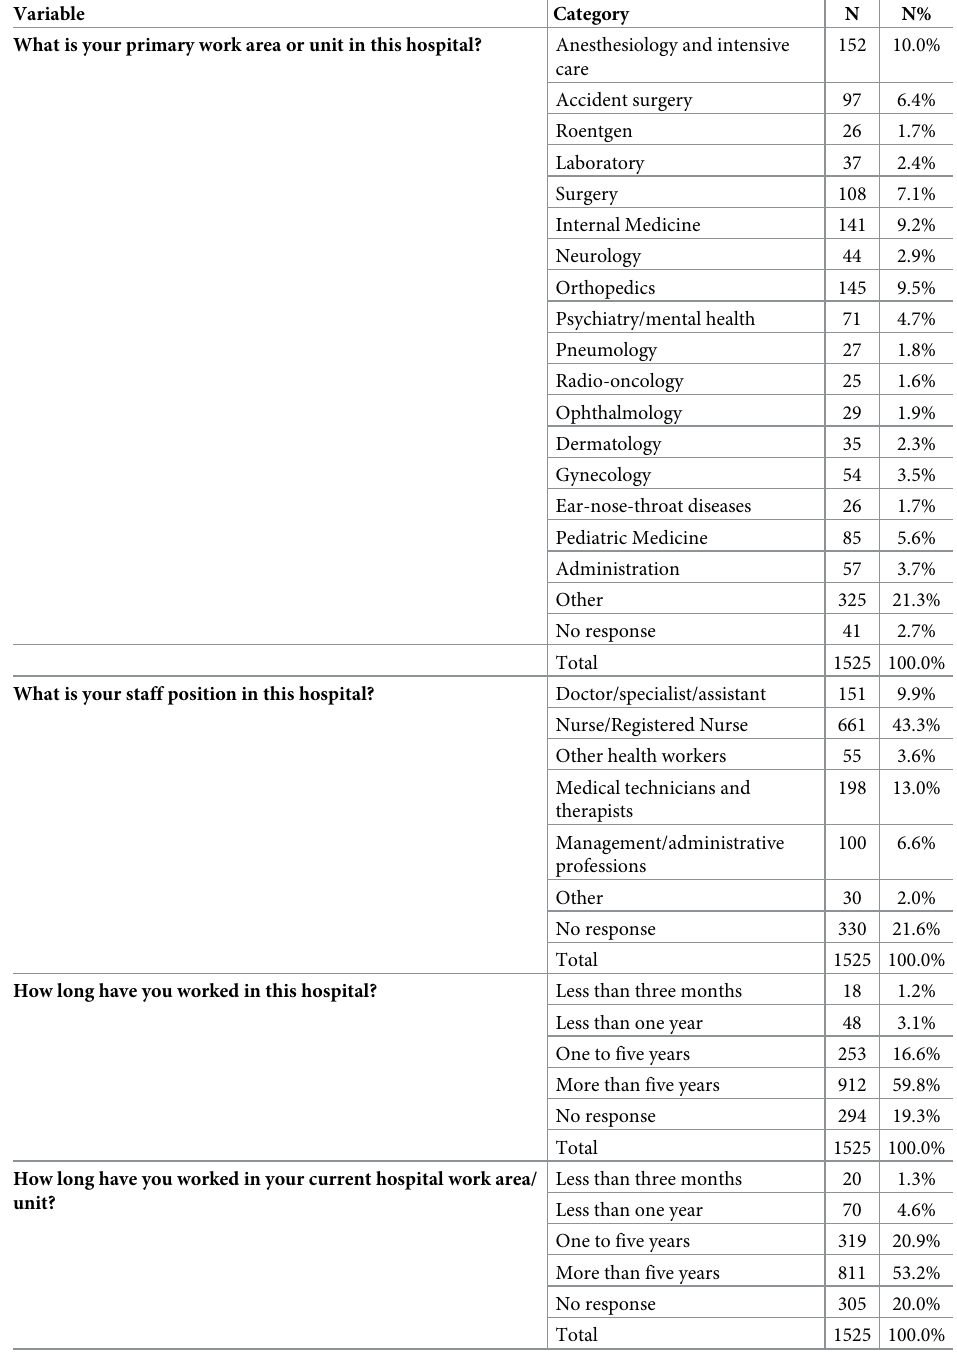
Table 2. Clinics and background information for